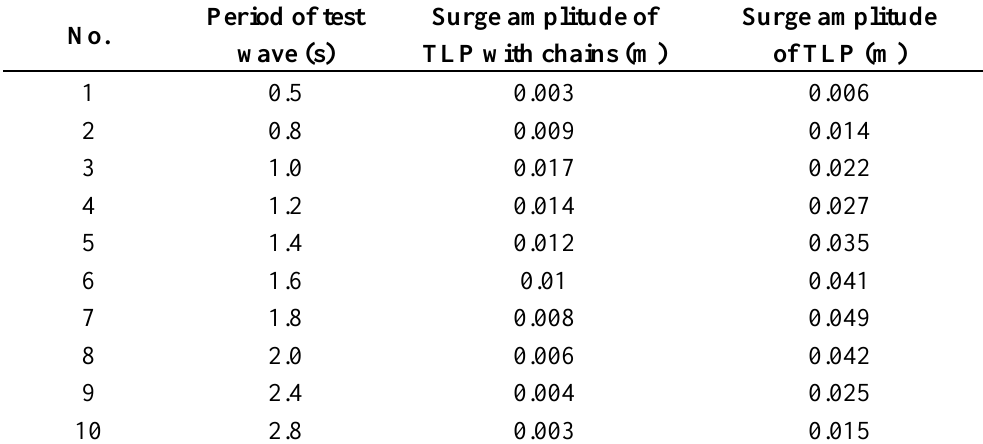
Table 5. Surge responses under a series of regular wave tests.